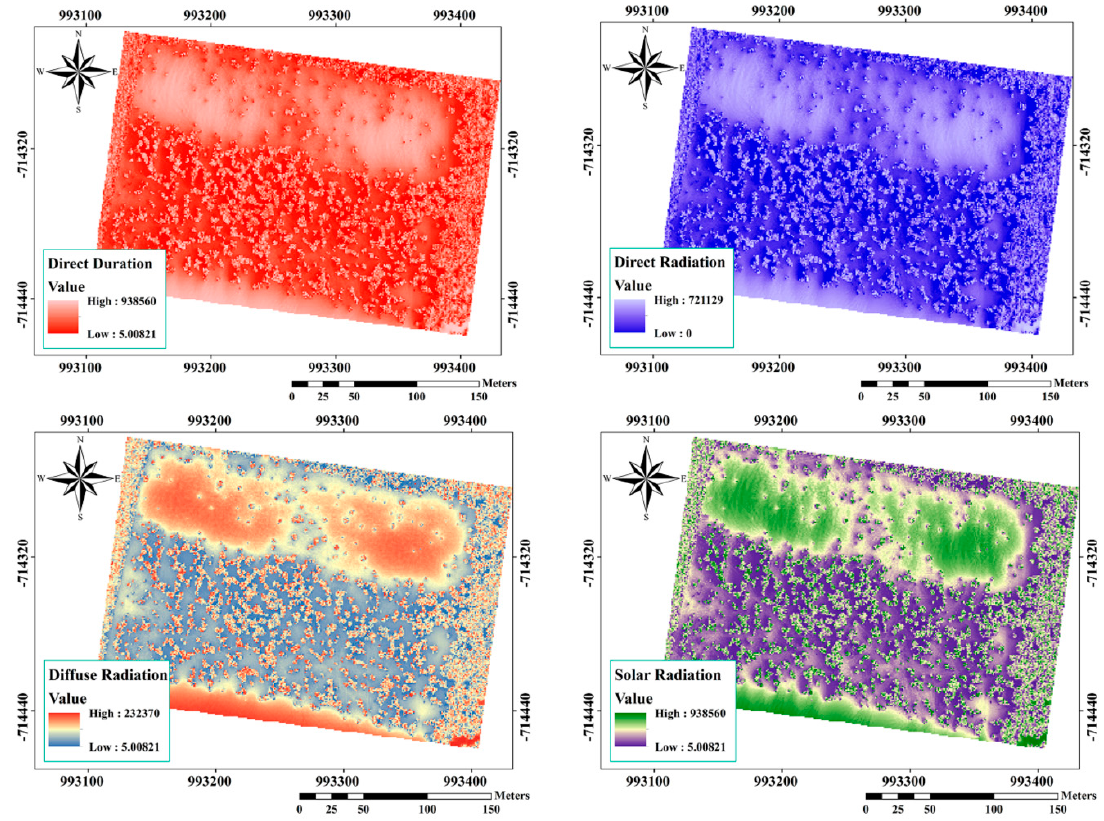
Figure 9. Produced layers of different types of potential solar radiation from the Unmanned Aerial Vehicle (UAV) RGB imagery in units of W·h/m 2 (average of growing season).